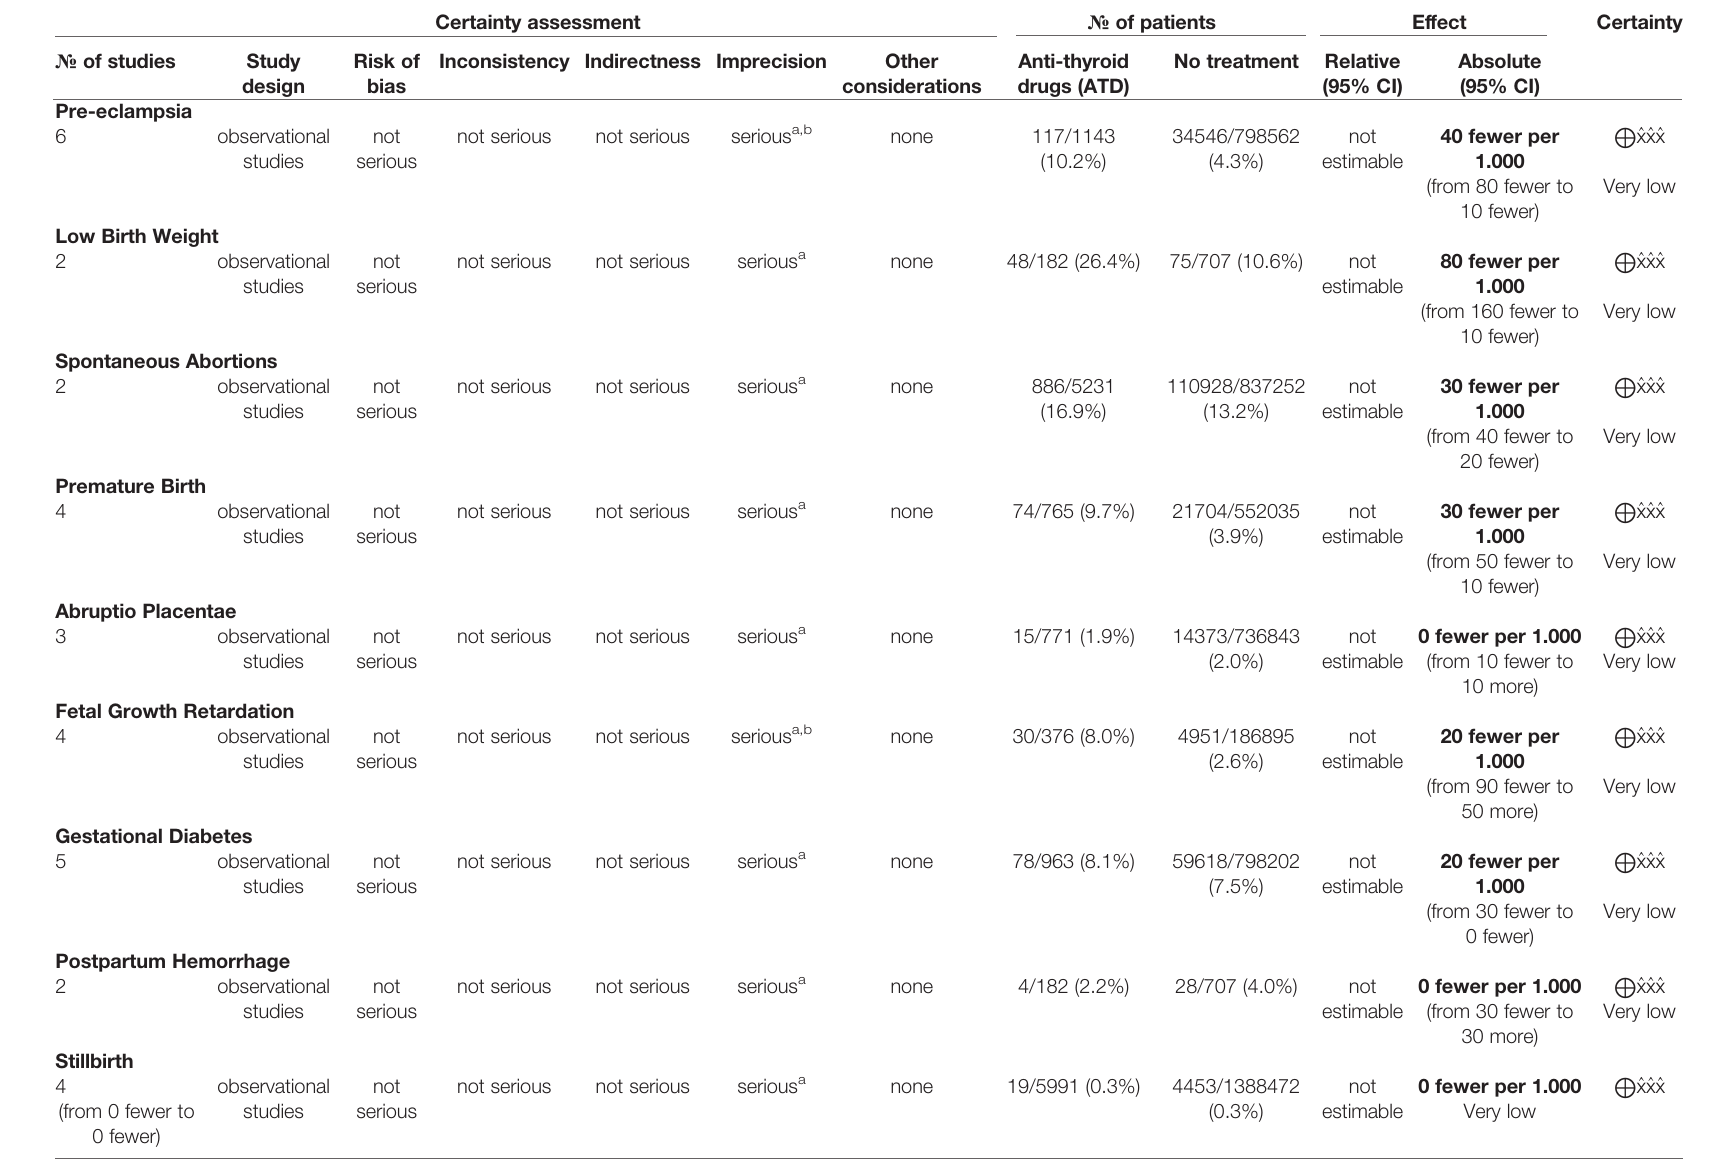
TABLE 3 | GRADE - certainty